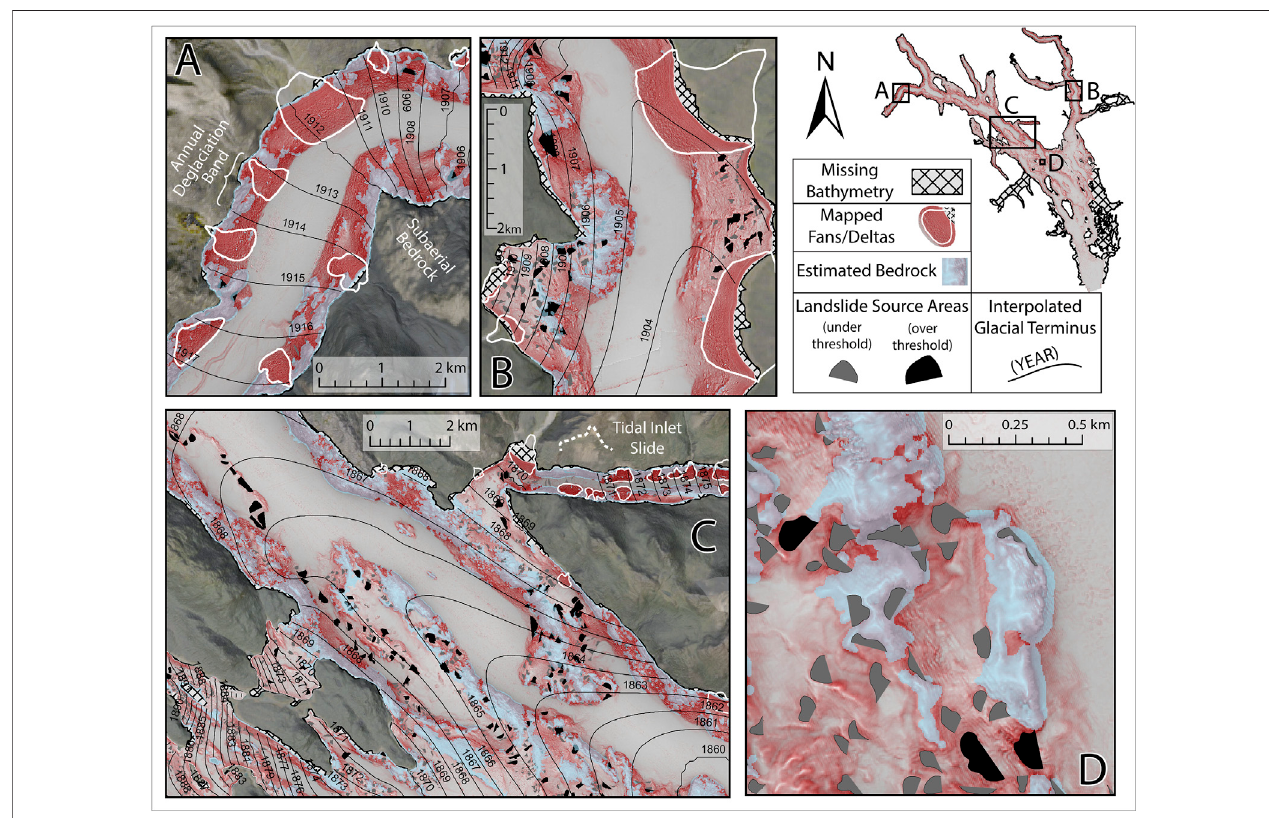
FIGURE 4 | Detailed maps of four locations (A – D) in Glacier Bay showing input data for this study. Background submarine imagery is a Red Relief Image Map (Chiba et al., 2008) derived from compiled bathymetry and shows an overlay of topographic openness (darker is more concave) and slope (redder is steeper). Interpolatedglacialterminuspositionsareplottedandrepresent annualdeglaciationbands,withanexampleshownin (A) .Maximumageforeachlandslideisexpressed as the year of earliest possible occurrence, derived from the encompassing deglaciation band. Locations of estimated bedrock based on slope, topographic openness, and surface roughness are shown in light blue. (A) shows an example of subaerial bedrock identi fi ed in satellite imagery and the IFSAR DEM with contiguous expression of modeled bedrock into bathymetric terrain. Subaqueous fans and deltas are delineated in white. Mapped landslide scarps are shown as their estimated source areas (connected at the end points). Landslides shown in black are those included in susceptibility assessment based on power law fi tting (see Figure 7 ). The Tidal Inlet landslide (Wieczorek et al., 2007) is visible in (C) . Overview map in the top right corner shows the locations of four included